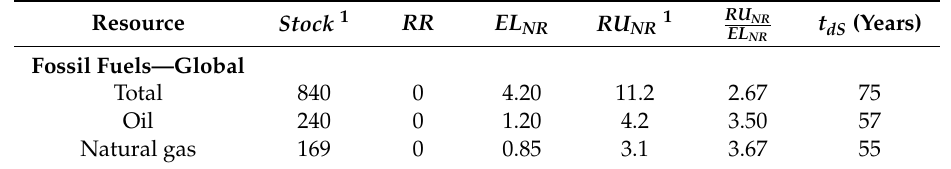
Table 1. Environmental sustainability assessment of global fossil fuel resources [ t S = 200